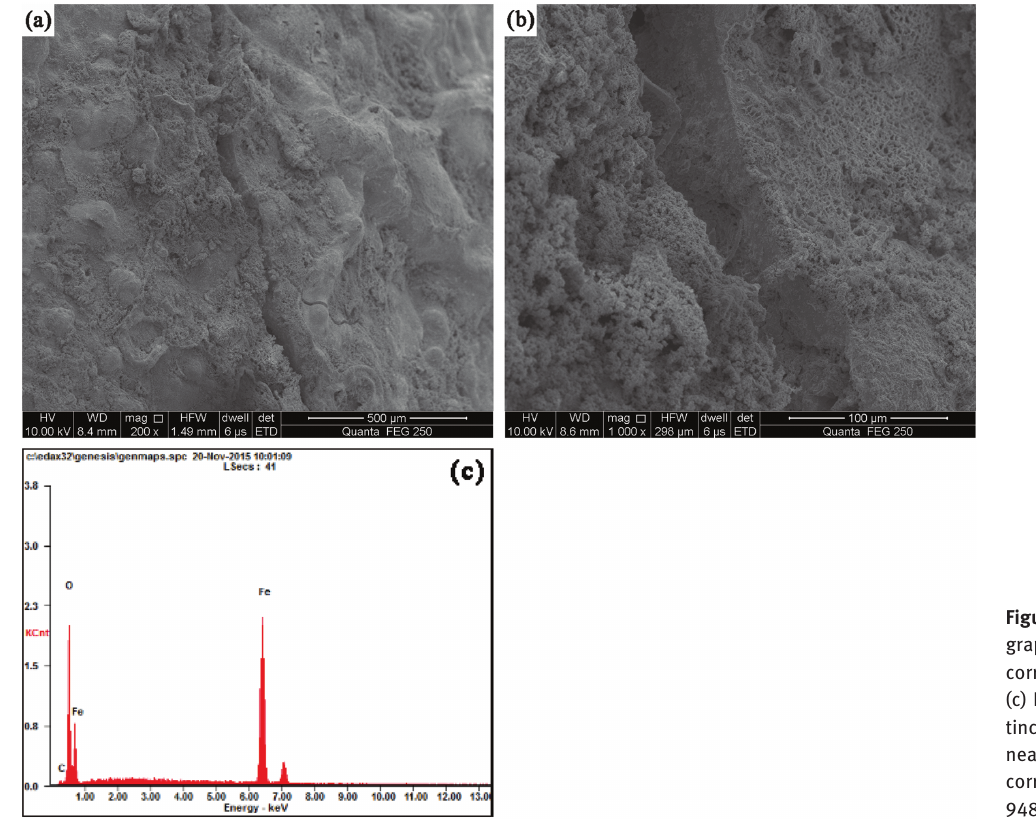
Table 5: Element content of the corrosive products on the surface